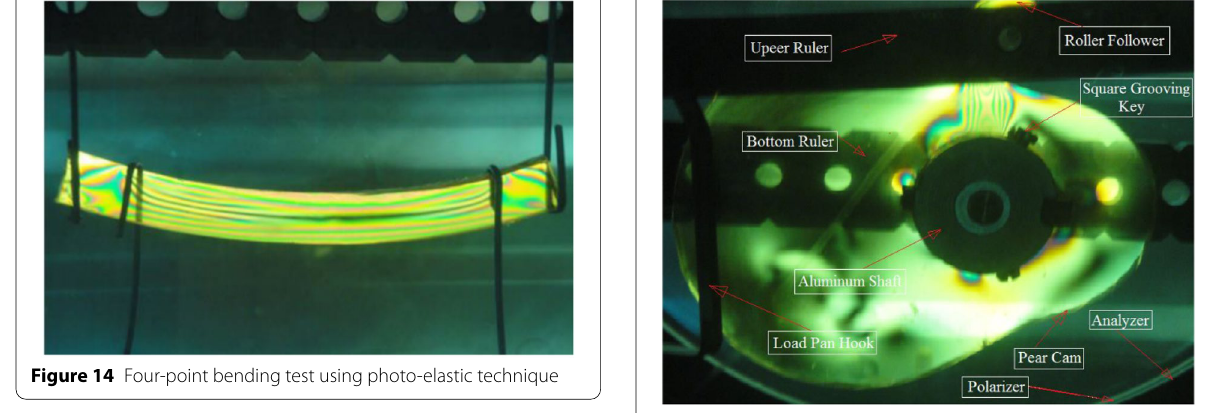
Figure 16 Stress analysis when the follower located at 90° with the cam